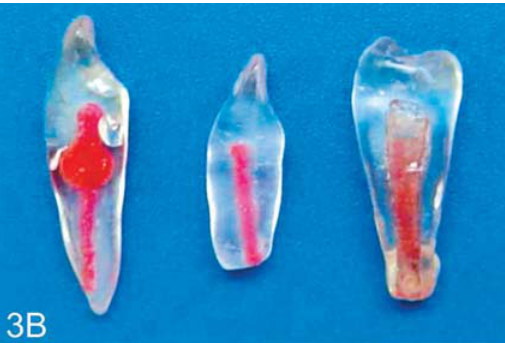
FIGURE 3B- Simulated pulp pathologies: internal resorption, external resorption, and periapical lesion associated with pulp